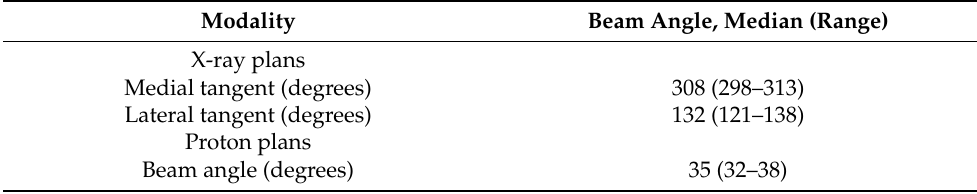
Table A3. Summary of beam